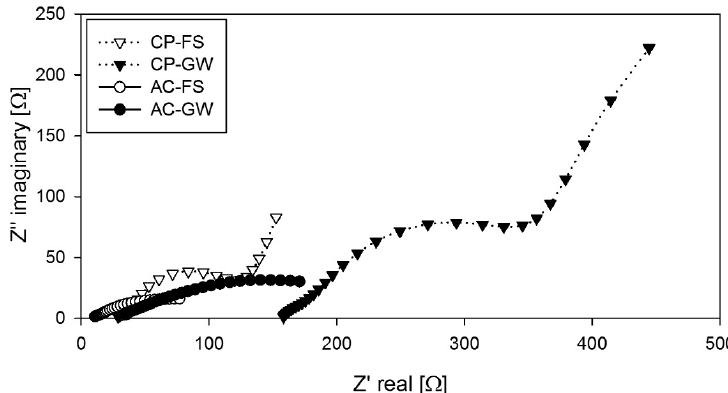
Figure 3. Nyquist plots of overall MFC impedance from CP and palm kernel shell AC determined by EIS.